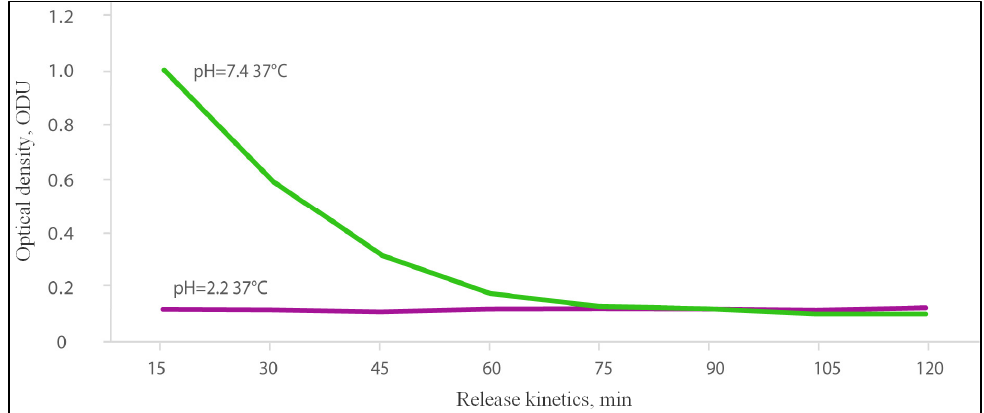
Figure 1. Kinetics of dye release from the sodium N-(2-sulfonatoethyl)chitosan gel in two different pH mediums at 37 ° С .